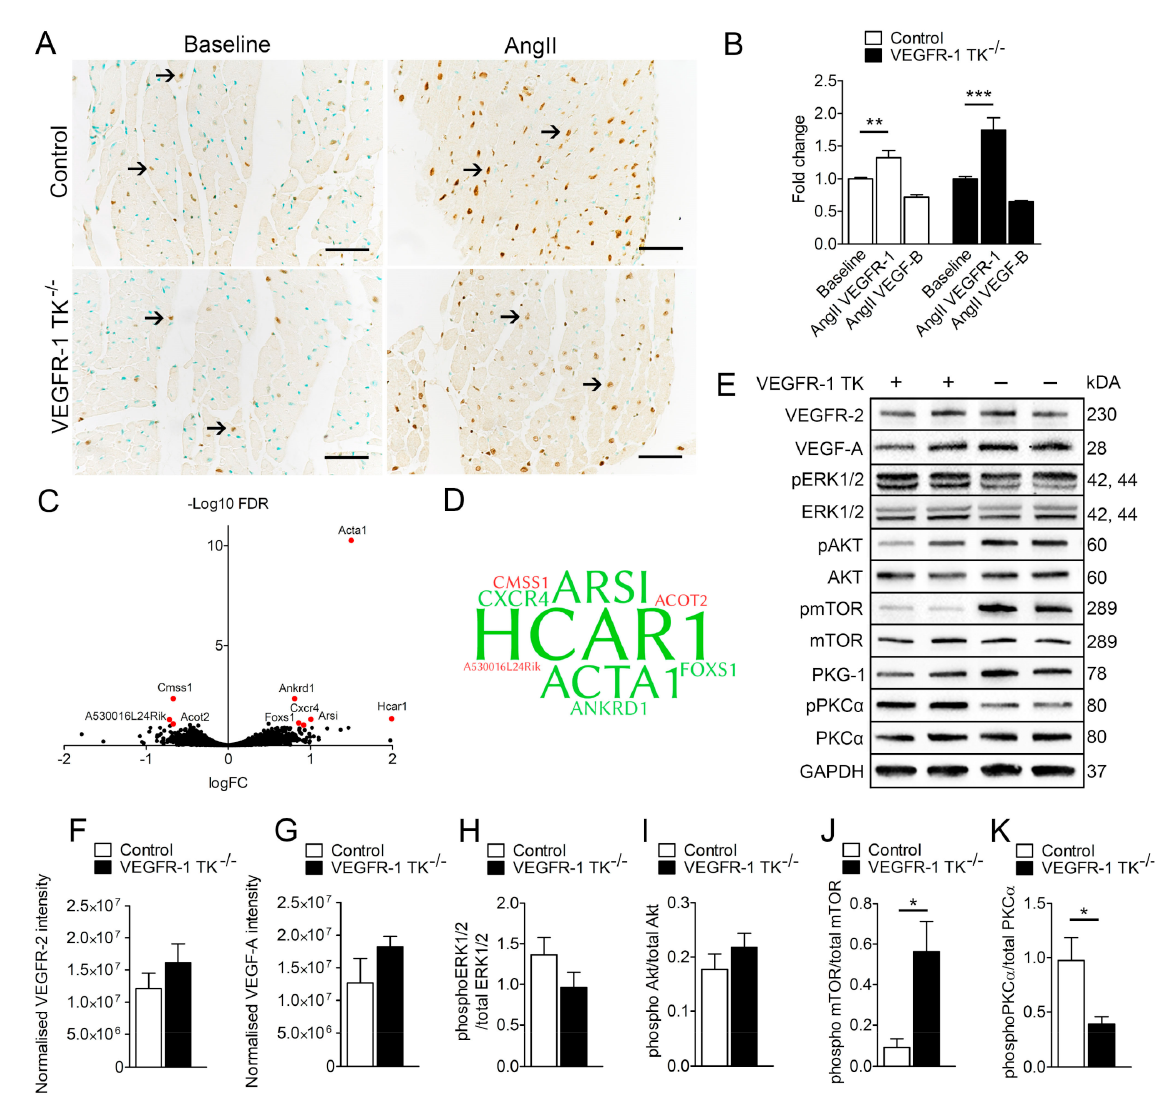
Figure 6. LVH increases VEGFR-1 expression in the myocardium. ( A ) Representative images of VEGFR-1 staining of the myocardium at baseline and after 14-day angII infusion. ( B ) Relative VEGFR-1 and VEGF-B expression measured with RT qPCR (n = 5–7/group). ( C ) RNA sequencing of LVs at day 14 of angII infusion. Volcano plot in which red represents significance in VEGFR-1 TK − / − mice compared to littermate controls with the use of a log fold change (logFC) >0.585 and false discovery rate (FDR) value of <0.10 (n = 4/group). ( D ) Word cloud presentation of differentially regulated genes found in RNA sequencing. Upregulated genes are marked with green and downregulated genes with a red colour. Larger word size correlates with higher fold change (n = 4/group). ( E ) Western blot analysis of LVH signaling cascades at day 14 of angII infusion. Quantification of VEGFR-2 ( F ), VEGF-A ( G ) phosphorylated ERK1/2 ( H ), Akt ( I ), mTOR ( J ) and PKC α ( K ) expression in LVs (n = 4–5/group). Values are mean ± SEM. Statistical analyses were performed using one-way ANOVA and Student’s t -test. *** p < 0.001; ** p < 0.01; * p <